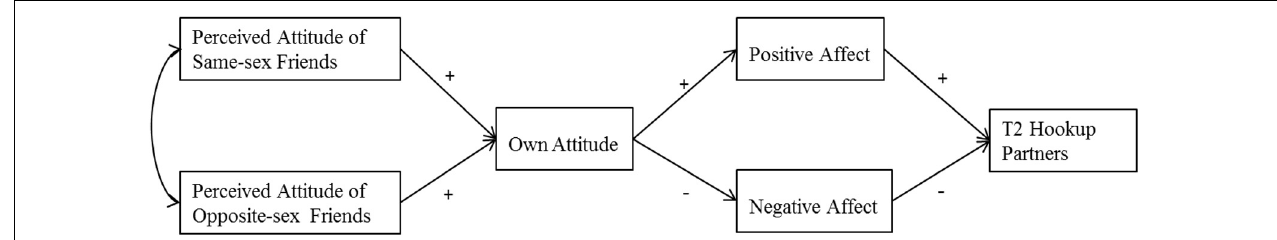
FIGURE 1 | Conceptual model of current research